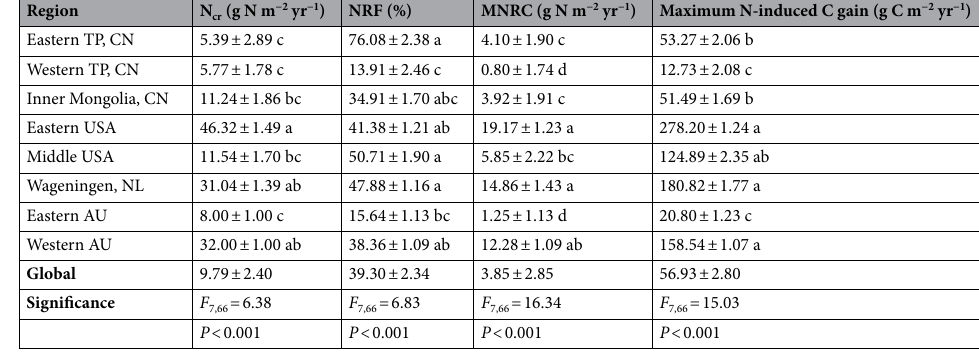
Table 1. Global differences in critical N rate (N cr ), N retention fraction (NRF) at N cr , maximum N retention capacity (MNRC) and maximum N-induced C gain. Data are shown as mean ± SD. F statistics for one-way ANOVAs are provided. Bold values indicate significance ( P < 0.05). The same letters in a column indicate insignificant differences ( P > 0.05) by Duncan’s new multiple range test among regions. CN, China; USA, America; NL, Netherlands; AU,